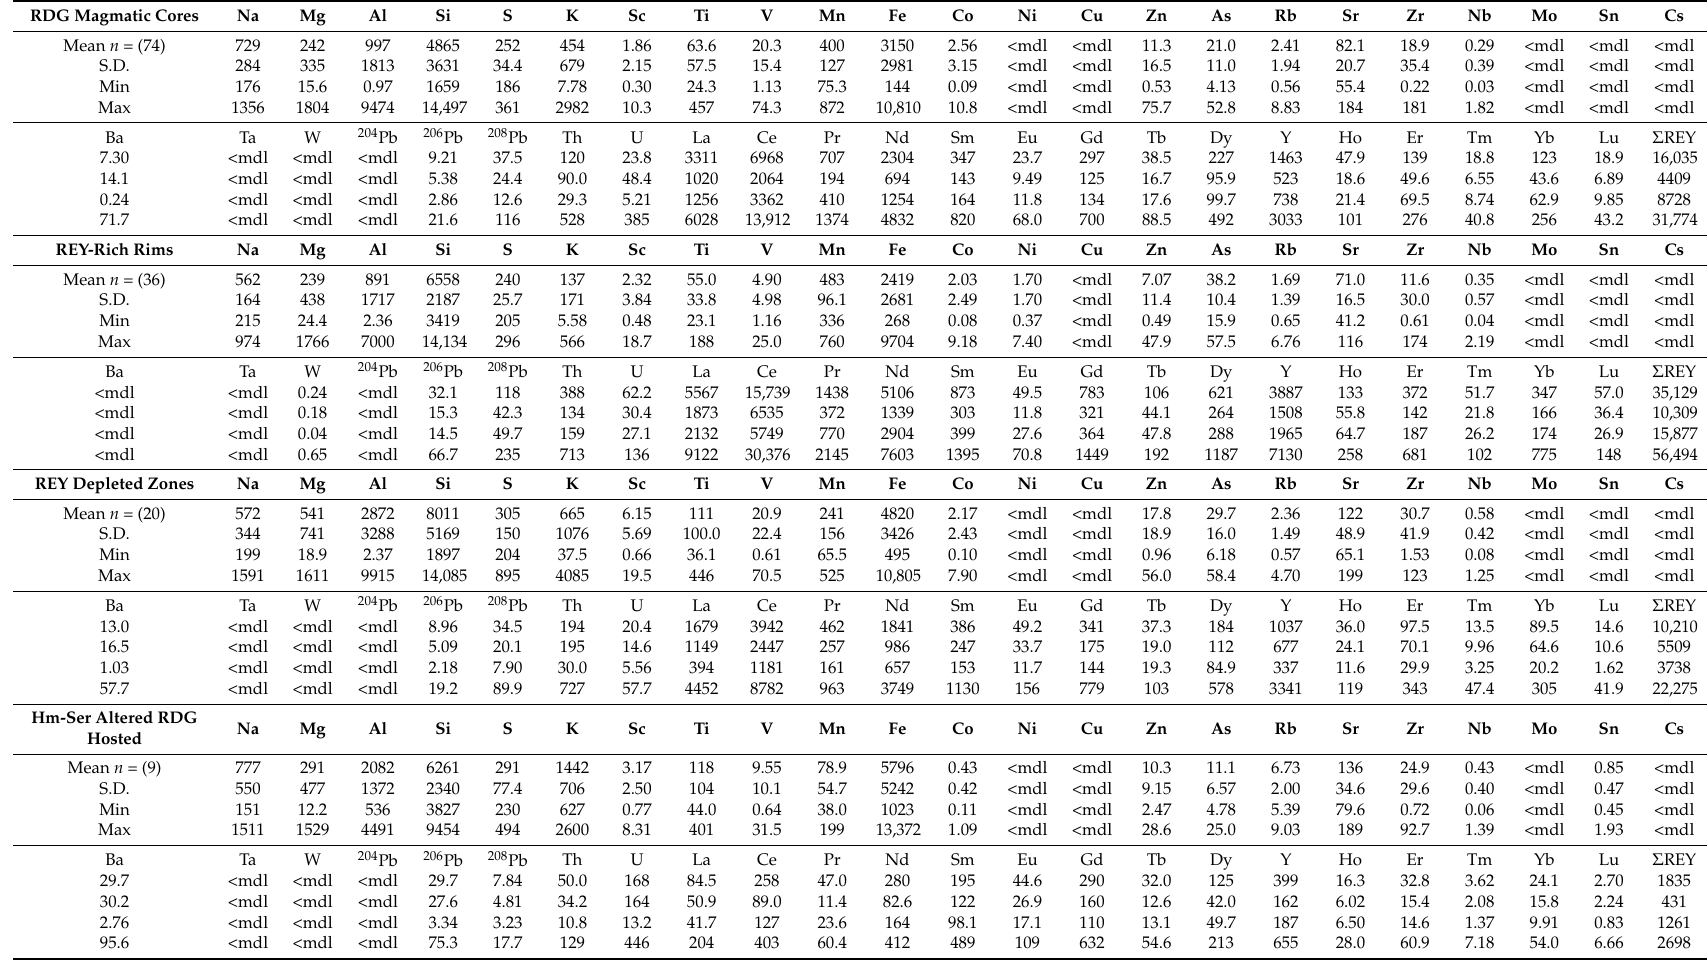
Table 2. Rare earth element (REE) and trace element concentrations in apatite from the Roxby Downs granite (ppm). Apatite analyses were performed on multiple grains in the following samples: RDG magmatic cores—2280-2, -3, -4, -5, -6, RX7860, RX7864, RX7866; REY-rich rims—2280-2, -3, -5; REY-depleted zones—2280-2, -3, -4, -5; Hm-Ser altered RDG hosted—2280-6. <mdl—below minimum detection